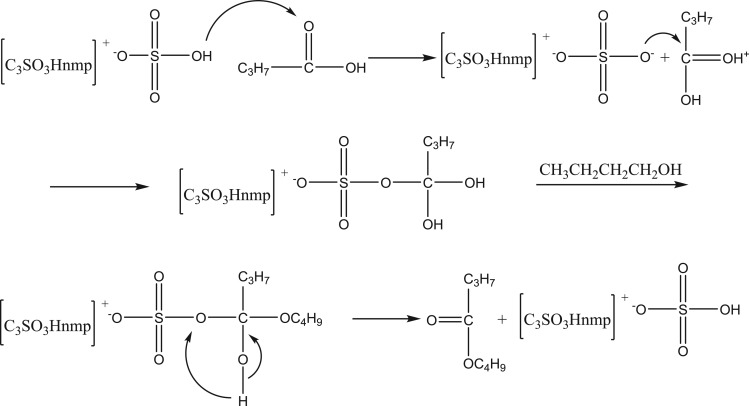
Esterification mechanism catalysed by immobilized [C3SO3Hnmp]HSO4.